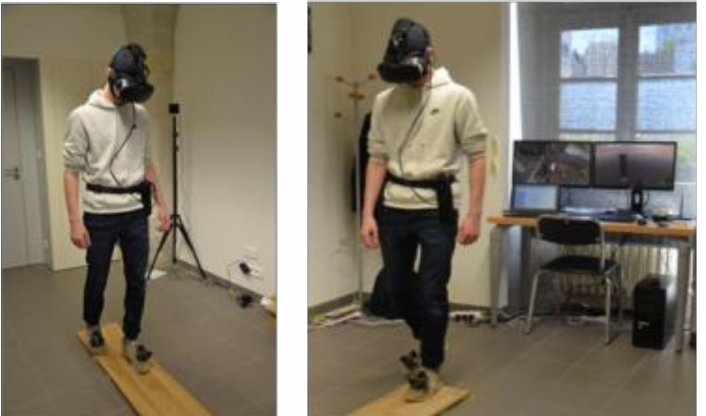
Figure 3. The participant on the plank is equipped with a tDCS cap, a VR helmet and two trackers attached to his feet. The computers in the room provided a 1st and 3rd person view of the participant’s virtual environment in real